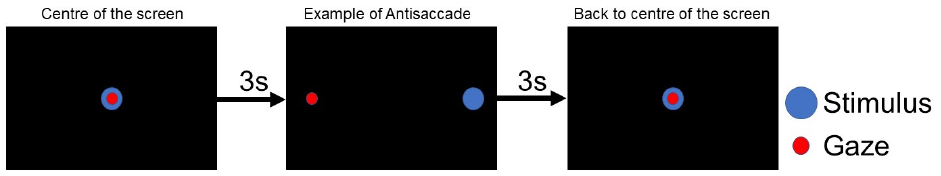
Figure 6. Antisaccade test scheme.